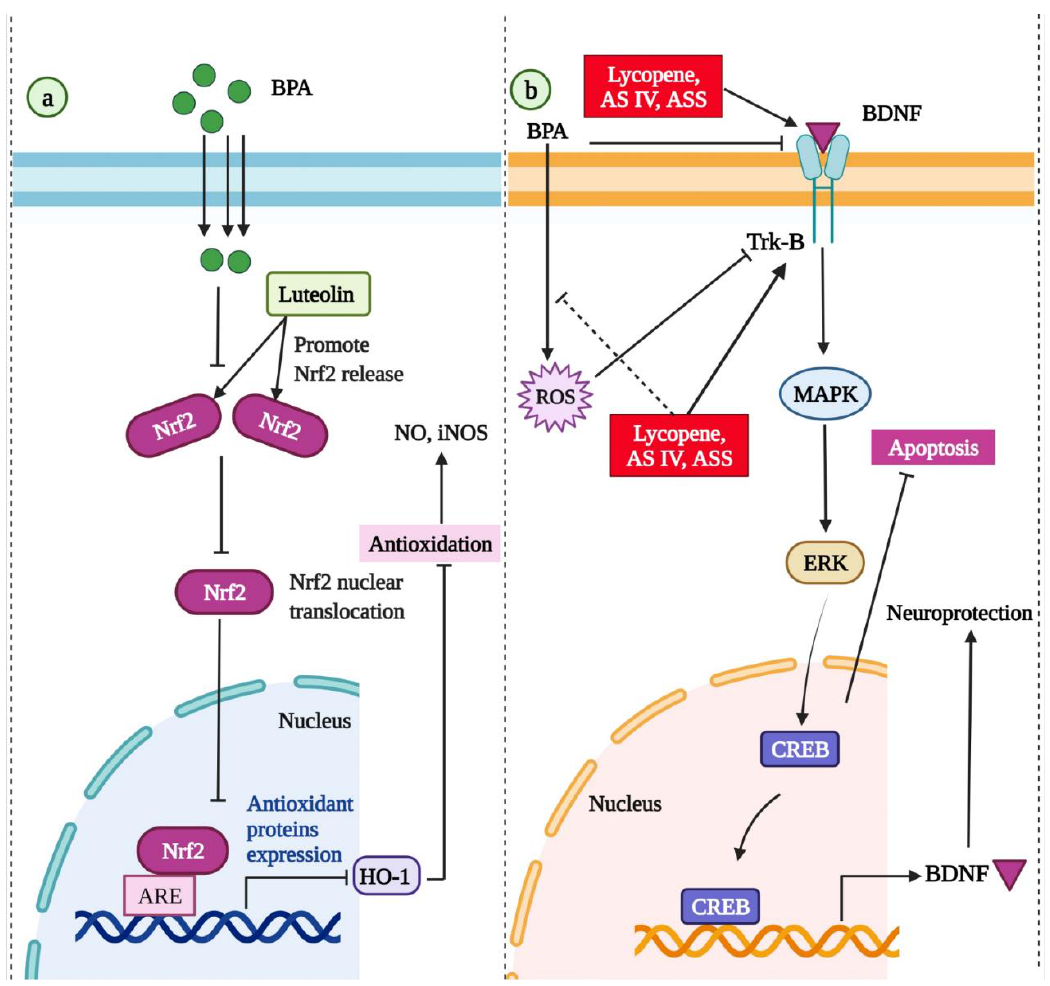
Figure 3. ( a ) The molecular mechanism of antioxidant effects of luteolin against BPA-induced renal toxicity through Nrf2/ARE/HO-1 pathway modulation [293]. ( b ) The molecular mechanism of lycopene [303], Astragalus spinosus saponins (ASS), and Astragaloside IV (AS IV) [304] against BPA exposure-induced neurotoxicity. Nrf2: nuclear factor-like 2; ARE: antioxidant response element; HO-1: heme oxygenase 1; BDNF: brain-derived neurotrophic factor; TrKb: tyrosine receptor kinase B; ERK: extracellular signal-regulated kinases; MAPK: mitogen-activated protein kinase; CREB: cAMP response element-binding